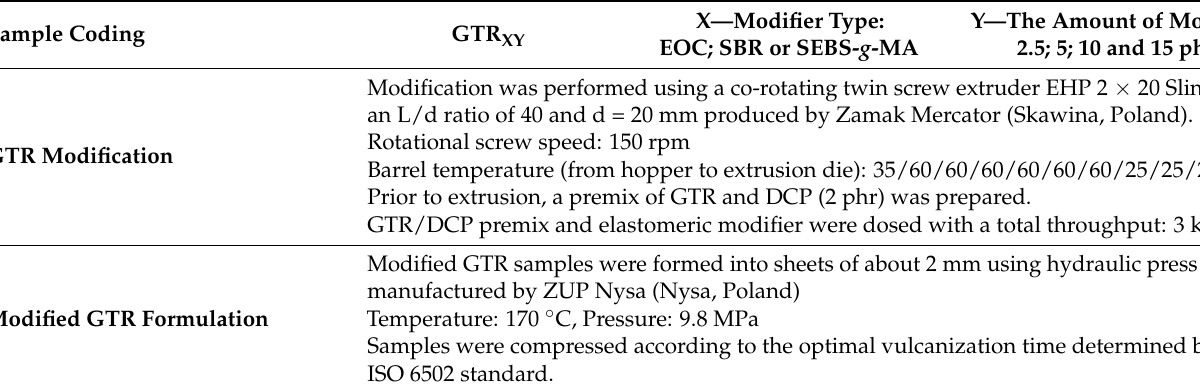
Table 1. Sample coding, GTR modification and formulation